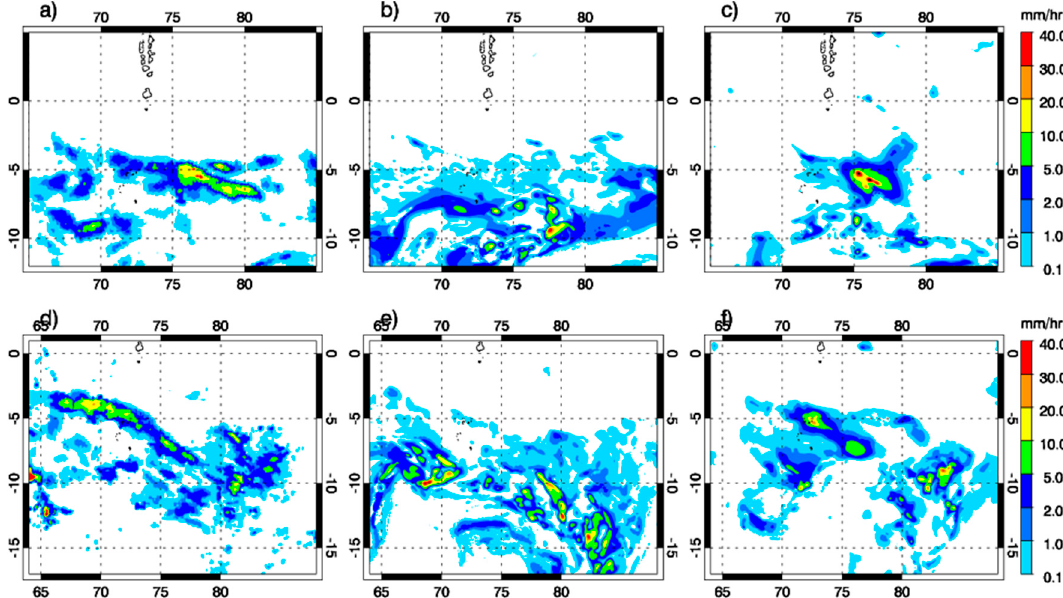
Figure 13. 1-h precipitation for convection related to the WWB event from ( a ) IMERG, ( b ) CTRL, ( c ) DA_com at 1200 UTC on 7 January 2018 and ( d ) IMERG, ( e ) CTRL, and ( f ) DA_com at 2100 UTC on